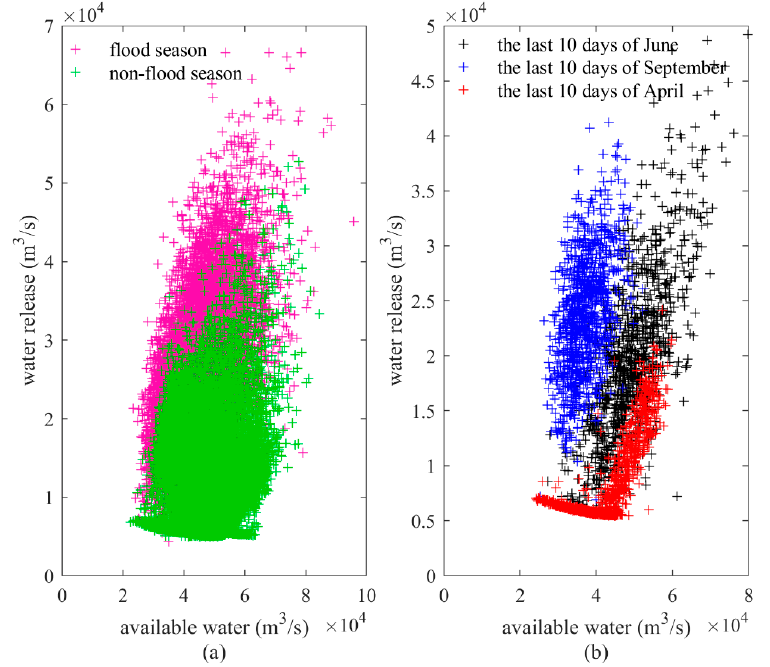
Figure 9. Scatter plots of optimal water release versus available water ( I i , j − 1 + V i , j / ∆ t plus signs and green plus signs denote the correlation between optimal water release and available water during flood season and non-flood season, respectively. ( b ) The black plus signs denote this correlation during the last 10 days of June, the blue plus signs denote this correlation during the last 10 days of September and the red plus signs denote this correlation during the last 10 days of April.